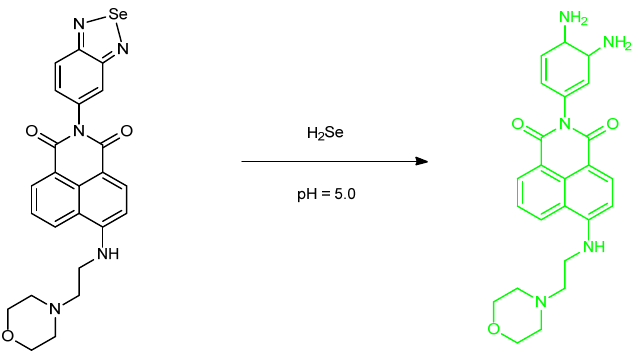
Figure 53. The structure and activity of the chemosensing probe that frees the Se from the N , N – chelation by Tian et al. The nature of the heterocycle changes dramatically; the native color of the 1,8–naphthalamide is restored.